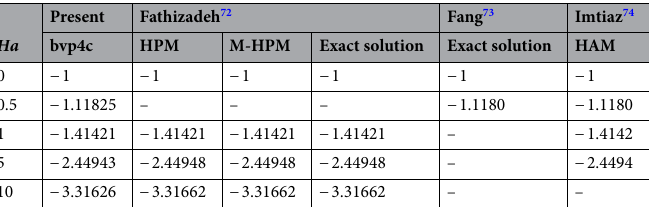
Table 4. Comparison of f ′′ ( 0 ) when ω 0, β α E L H 1 H 2 = = = = = = → ∞ present